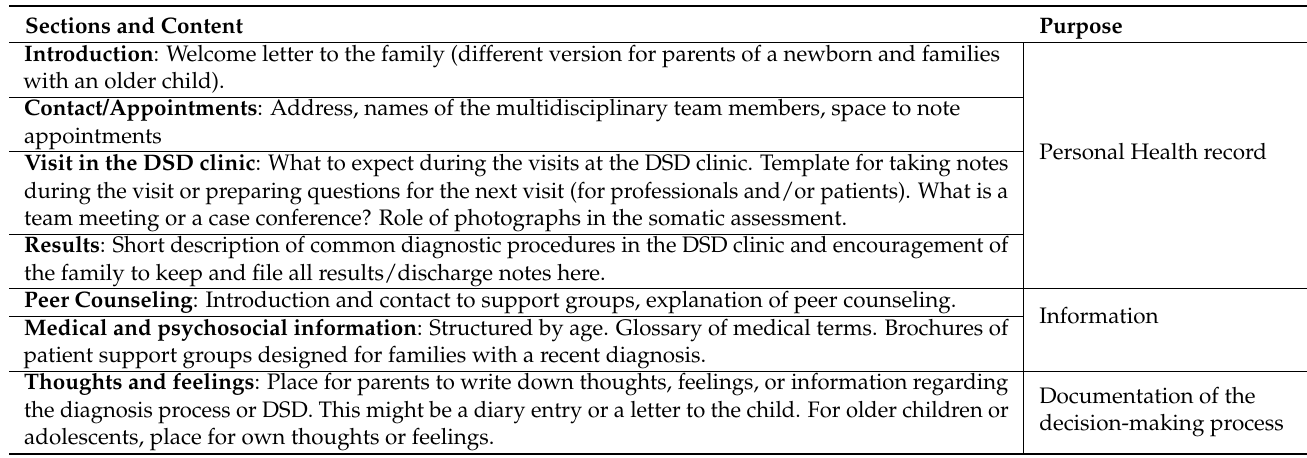
Table 3. Sections and content of “My